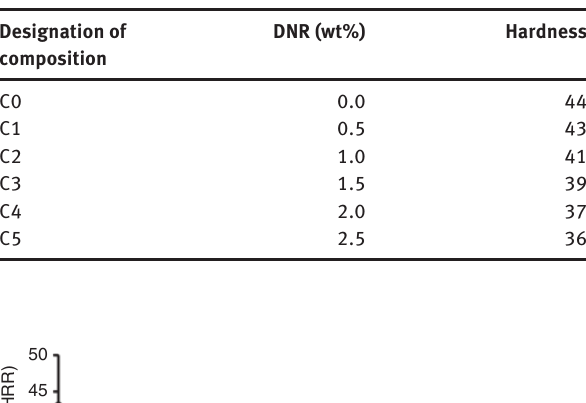
Figure 6 Hardness of cured epoxy filled with different weight percentages of DNR. Table 3 Hardness of cured epoxy filled with different weight percentages of DNR.